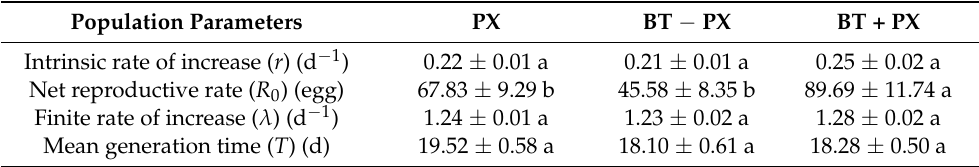
Table 4. Population parameters (M ± SE) of Plutella xylostella when feeding on Chinese kale alone (PX), with prior whitefly damage (BT − PX) or with simultaneous whitefly damage (BT + PX). Population